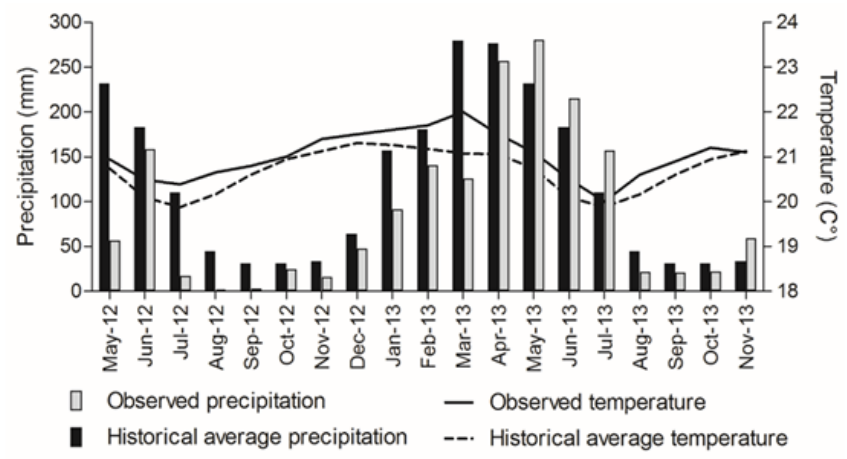
Figure 2. Climatic